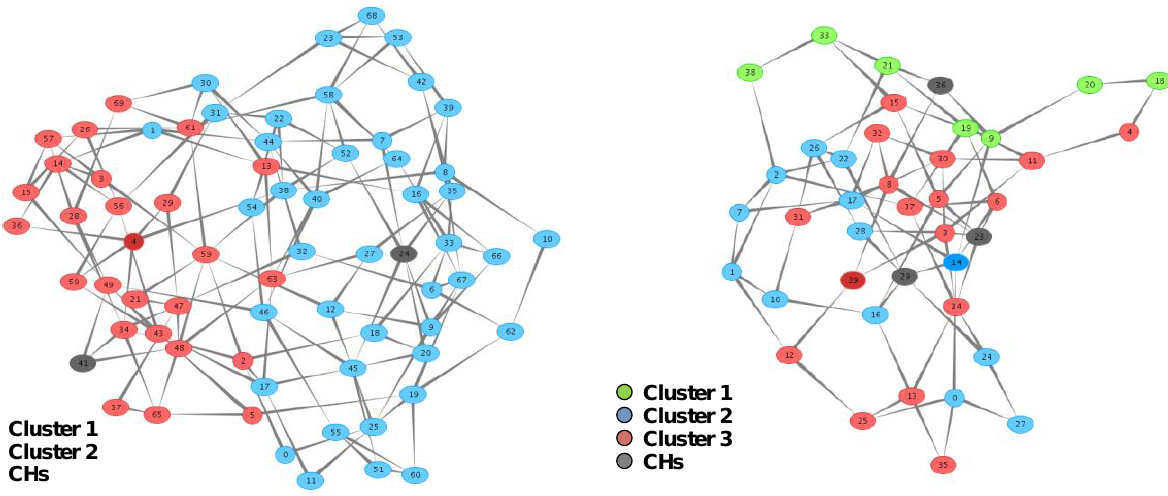
Figure 12. Cluster